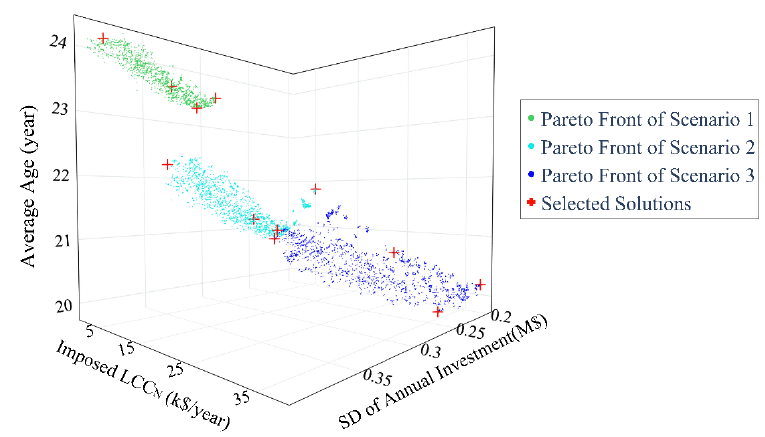
Figure 7. Comparison of nondominated Pareto solutions for three scenarios.